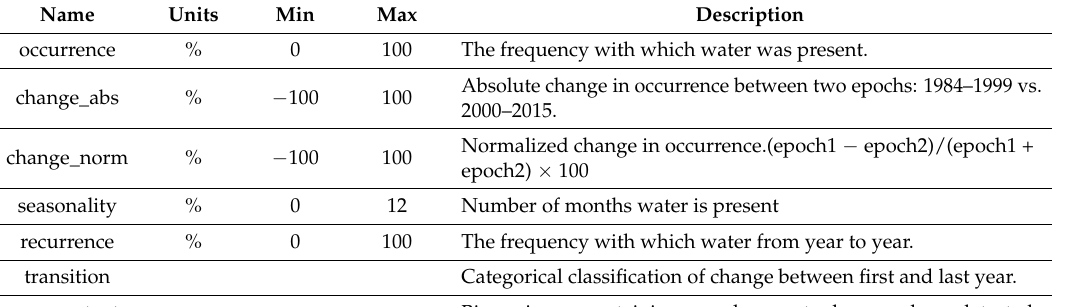
Table 5. The basic information of seven bands of global surface water dataset.